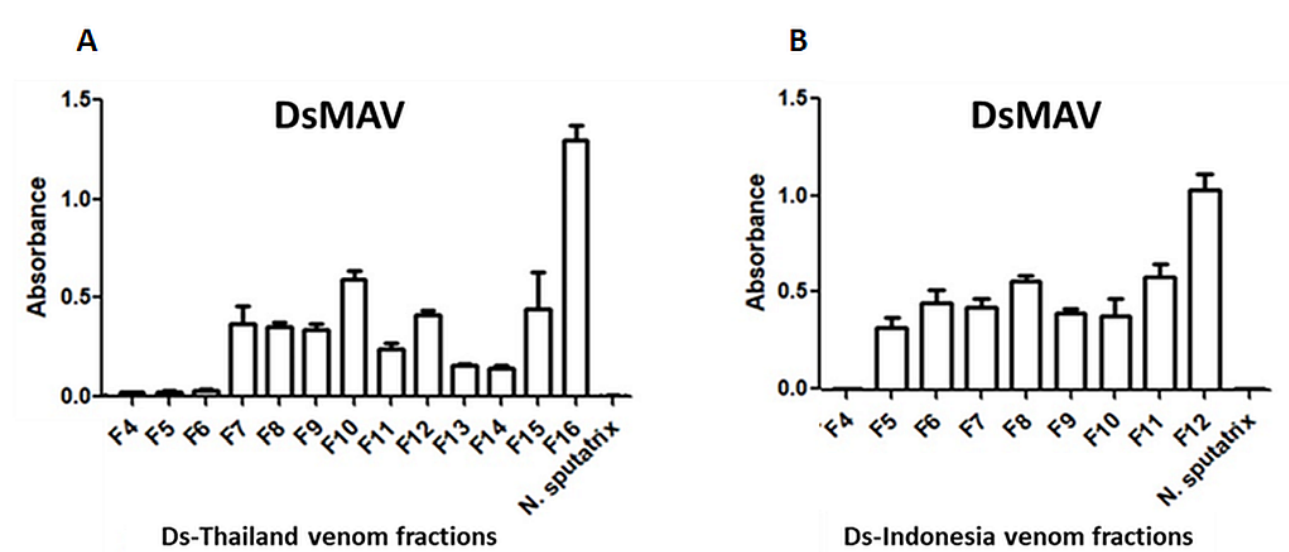
Figure 3. Immunoreactivity of Thai Daboia siamensis monovalent antivenom (DsMAV-Thailand) toward HPLC venom protein fractions of D. siamensis from (A) Thailand and (B) Indonesia. Naja sputatrix venom was used as negative control. Absorbance values were obtained by indirect ELISA and expressed as mean ± S.E.M. from three independent experiments.